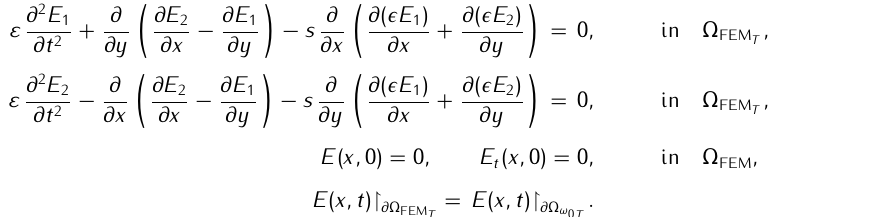
Figure 10. Test 1. Behavior of the exact and computed at the center of the computational domain Ω point (0 . 5 , 1 . 0) , which is located close to the center of Ω show the comparison of solutions with amplitude values A = 4 , 12 , 26 , 37 , 51 in (46) . Here, the horizontal axis denotes the computation